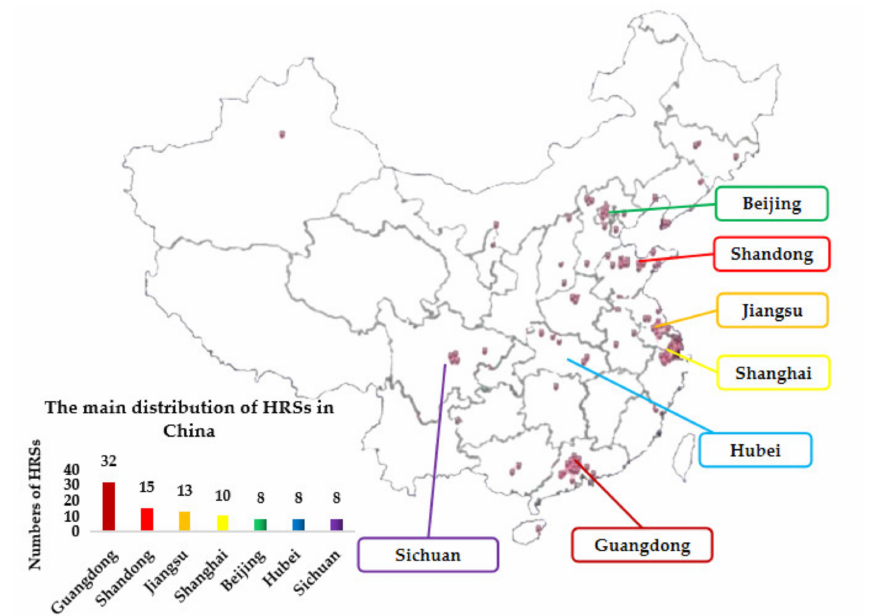
Figure 5. The Main Distribution of HRSs in China